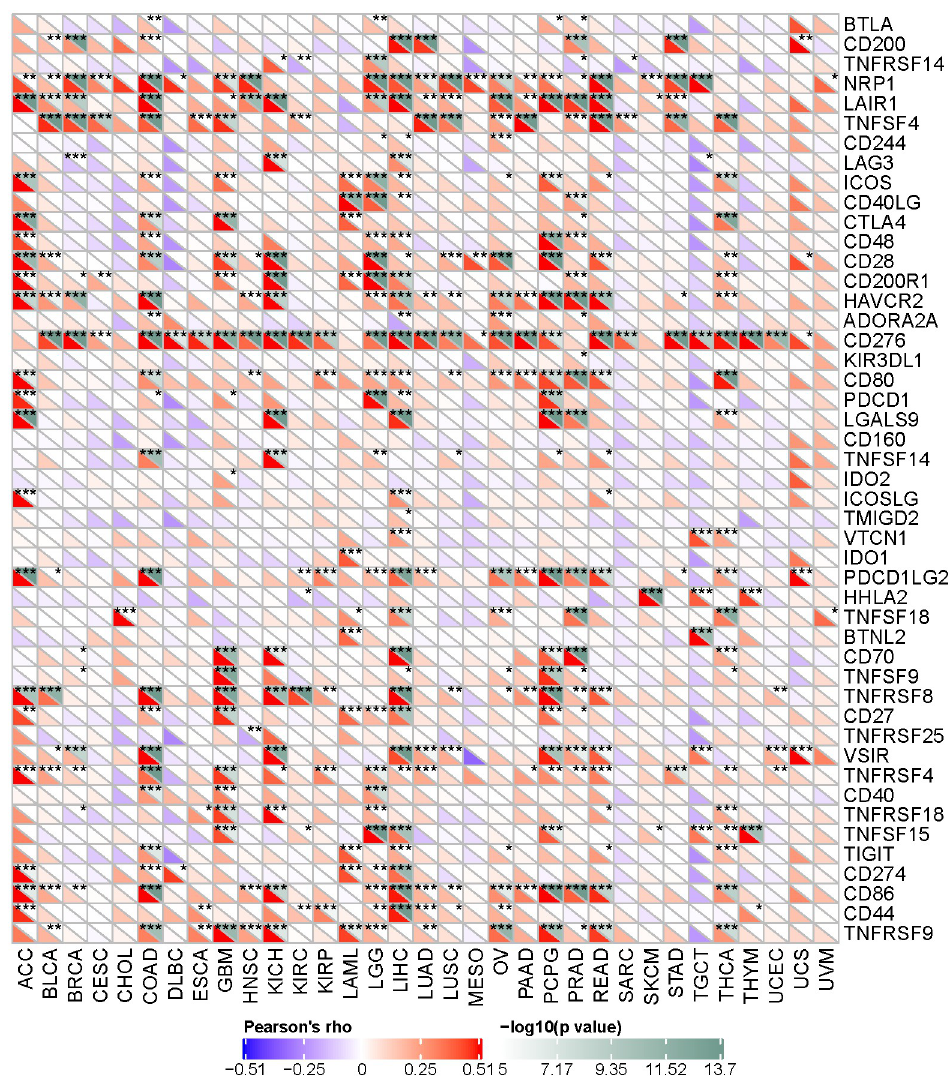
Fig 8. Correlation of the expression between COL1A1 and immune checkpoint genes in different tumors. Based on Pearson correlation coefficients, COL1A1 has a significant correlation with most selected immune checkpoint genes in LGG( � P < 0.05; �� P < 0.005; ��� P <